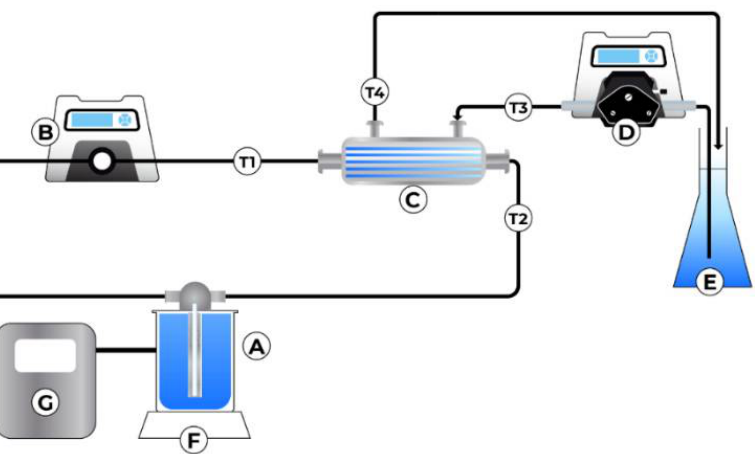
Figure 2. Schematic diagram of the membrane distillation crystallization setup: A feed solution; B gear pump; C membrane contactor; D peristaltic pump; E osmotic solution; F balance; G water bath/cooler; T1–T4 thermometers.